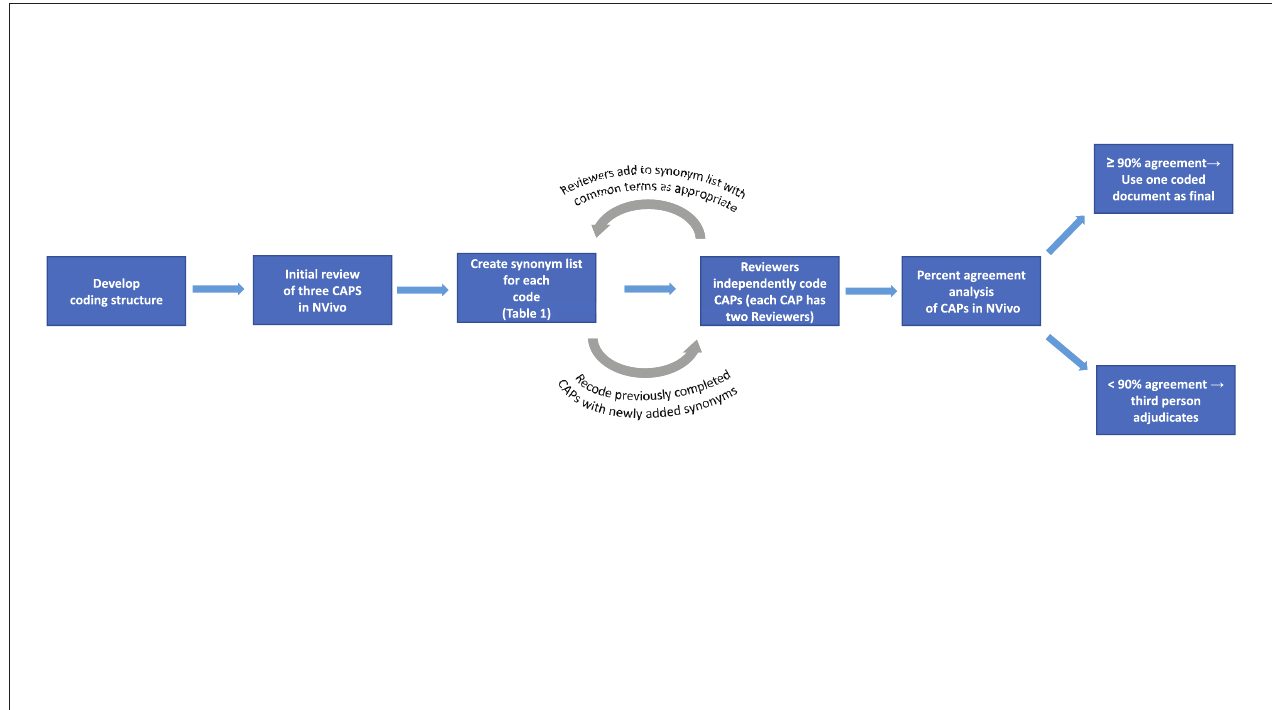
FIGURE 1 | Overview of workflow used to identify references to environmental exposures, equity, health effects, and health co-benefits in urban Climate Action Plans.